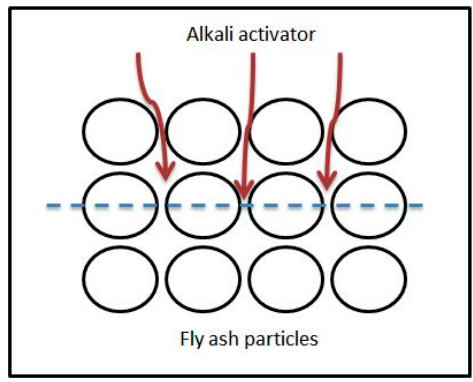
Figure 2. Inter-particle gelation of an alkali activator.